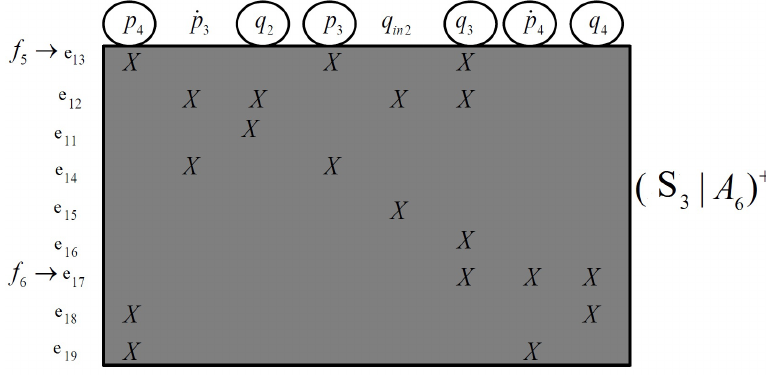
Figure 9. DM decomposition of ( S 3 | A 6 )